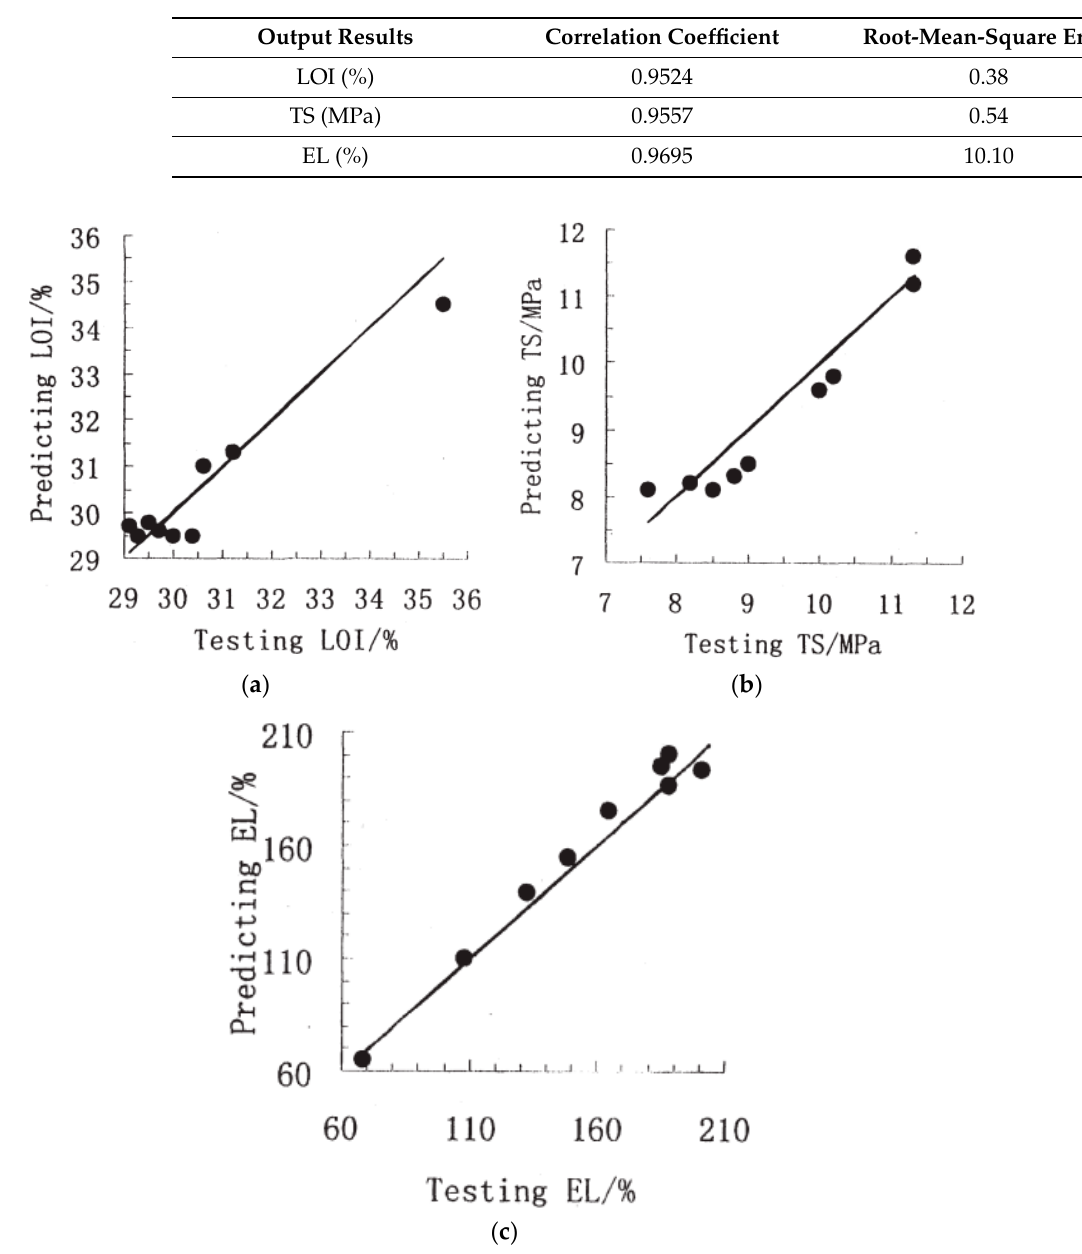
Table 7. Typical descriptors used in AI/ML models to predict the fire performance of flame-retardant materials. Materials Method Target Output